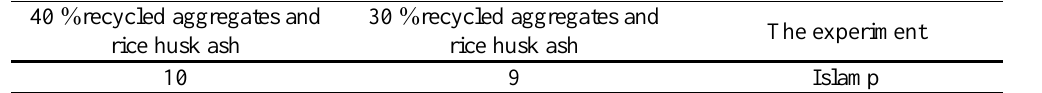
Figure 6. Performing a slump test . Table 12. Slump